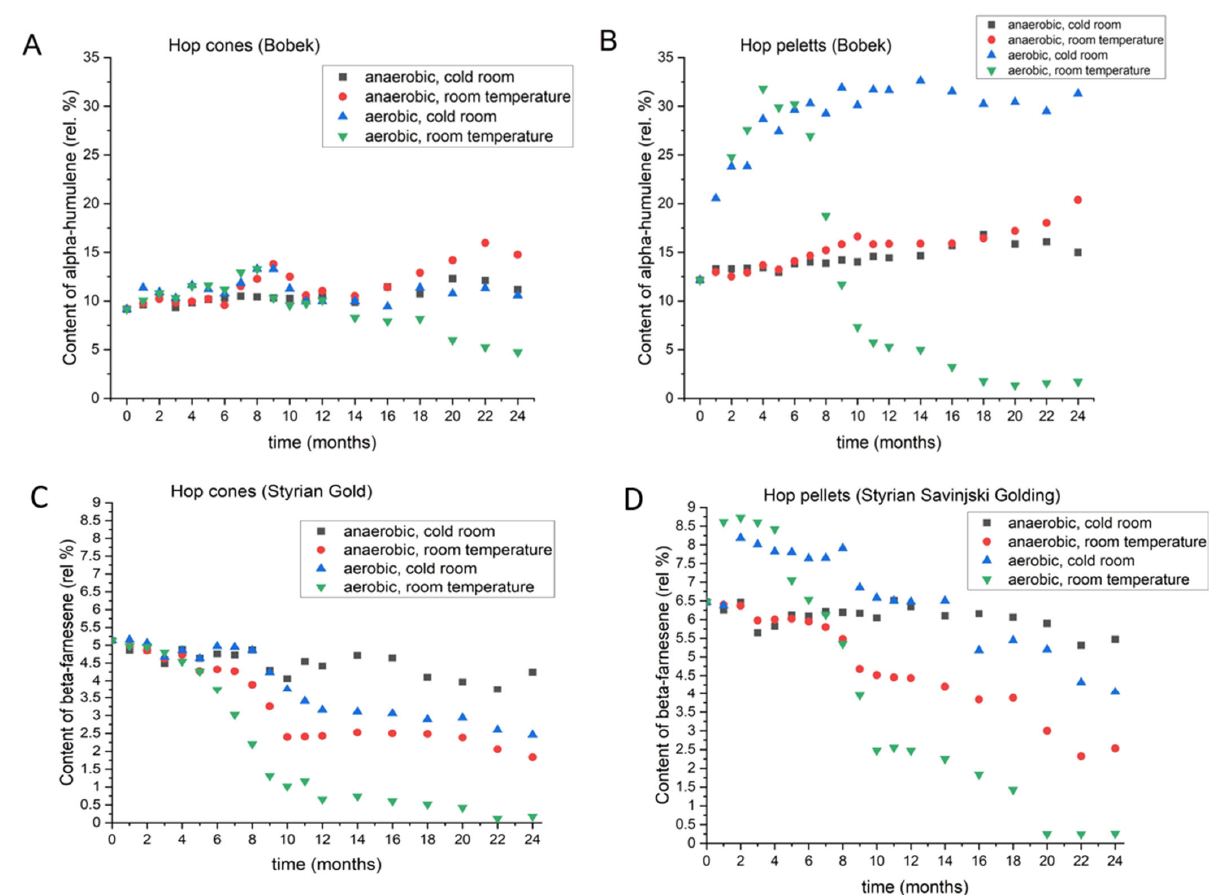
Figure 8. Changes in the content of alpha-humulene in Bobek cones ( A ) and pellets ( B ) and changes in the content of beta-farnesene in Styrian Golding cones ( C ) and Savinjski Golding pellets ( D ) during two-year period, under different storage conditions.